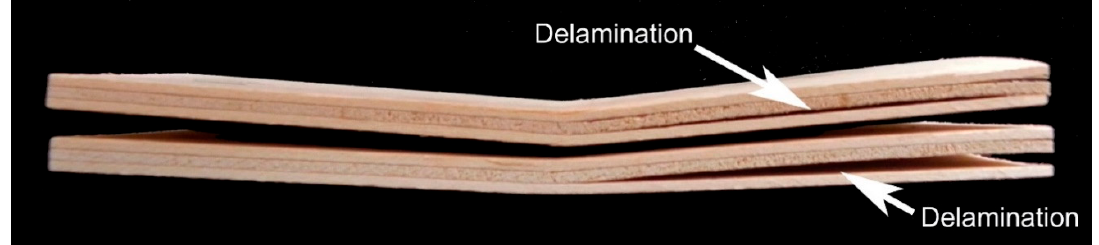
Figure 9. Delamination in the plywood samples prepared at 140 °C and 1 min during the determination of bending strength.